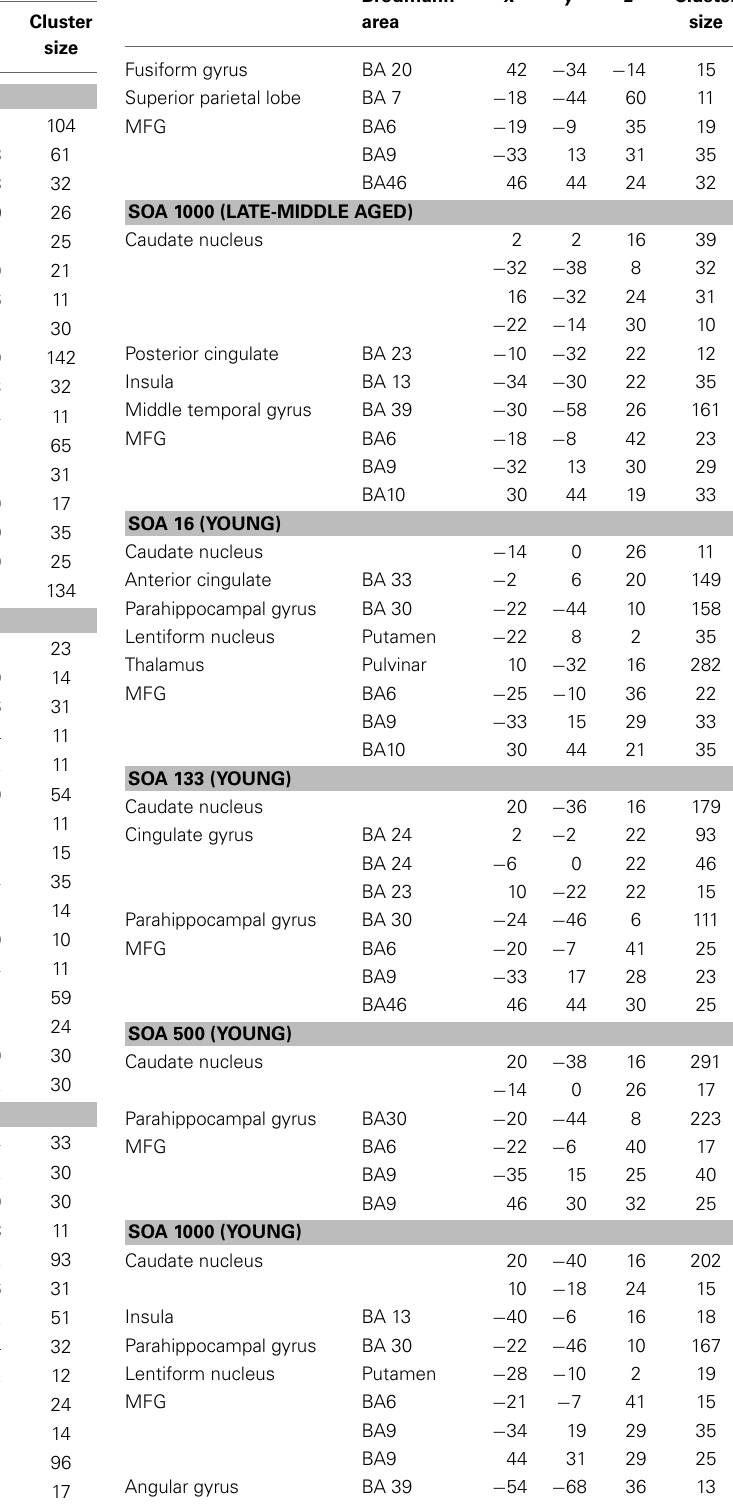
Table 2 | Results of the random effects analyses ( p < 0 . 001; k > 10